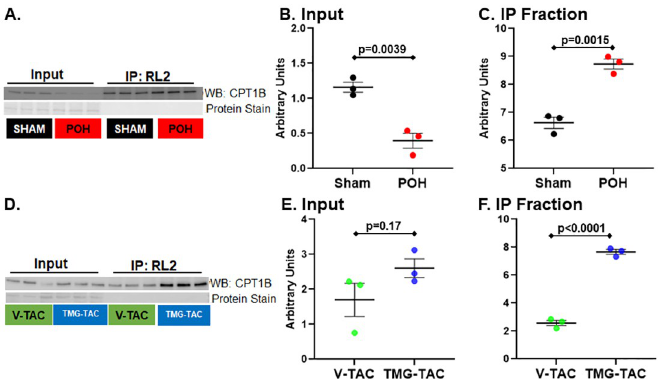
Fig 4. O-GlcNAc immunoprecipitation (IP) for carnitine palmitoyltransferase 1B (CPT1B). CPT1B western blots are show prior to (input) and after IP with the anti-O-GlcNAc antibody RL2 in POH and Sham (A) with quantification for input normalized to protein staining (B) and after IP (C). Western blots for experimental groups V-TAC and TMG-TAC are shown in D with quantification for input normalized to protein staining (E) and after IP (F). Bars indicate mean ± standard error of the mean. N = 3 per group.